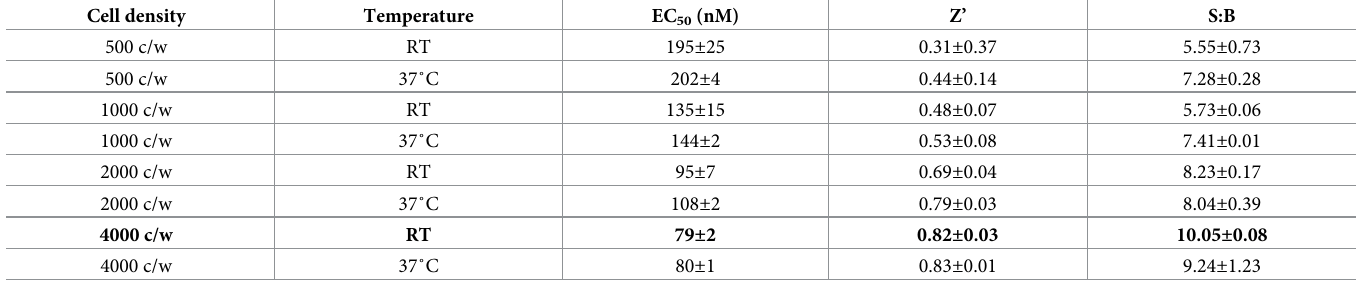
Table 1. Assay metrics under specified conditions. EC 50 , Z’ and S:B were determined for Sm .TRPM PZQ activation by PZQ at indicated cell densities and temperatures. Conditions in bold text indicate the final conditions selected for the screen. For each condition, responses were found to be positively cooperative (Hill coefficients range of